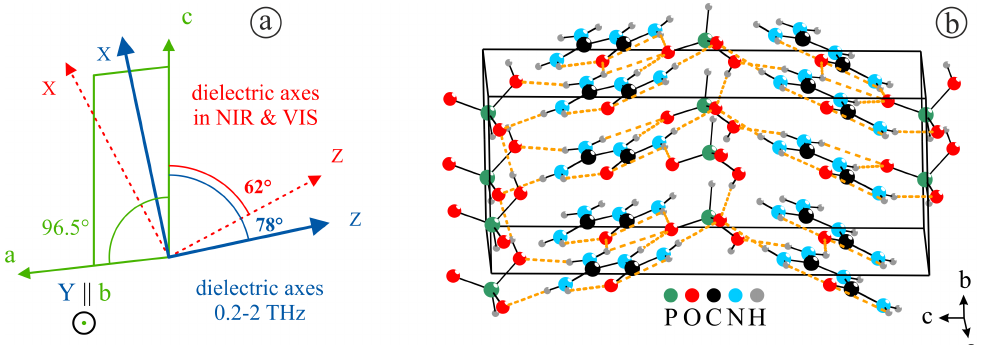
Figure 23. ( a ) Assignment of the crystallographic and principal dielectric axes of monoclinic GUHP; ( b ) Crystal structure of GUHP (the .cif files taken from the CCDC database can be found in the Supplementary Materials).